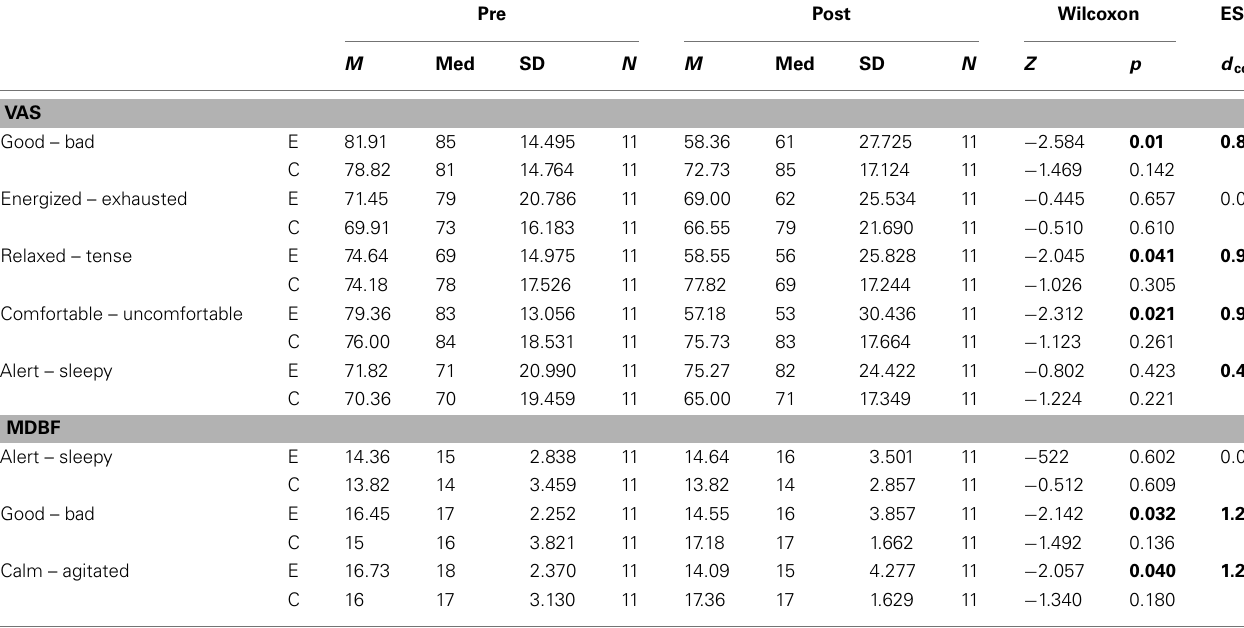
Table 1 | Results of statistical analysis of the (A)VAS and (B)